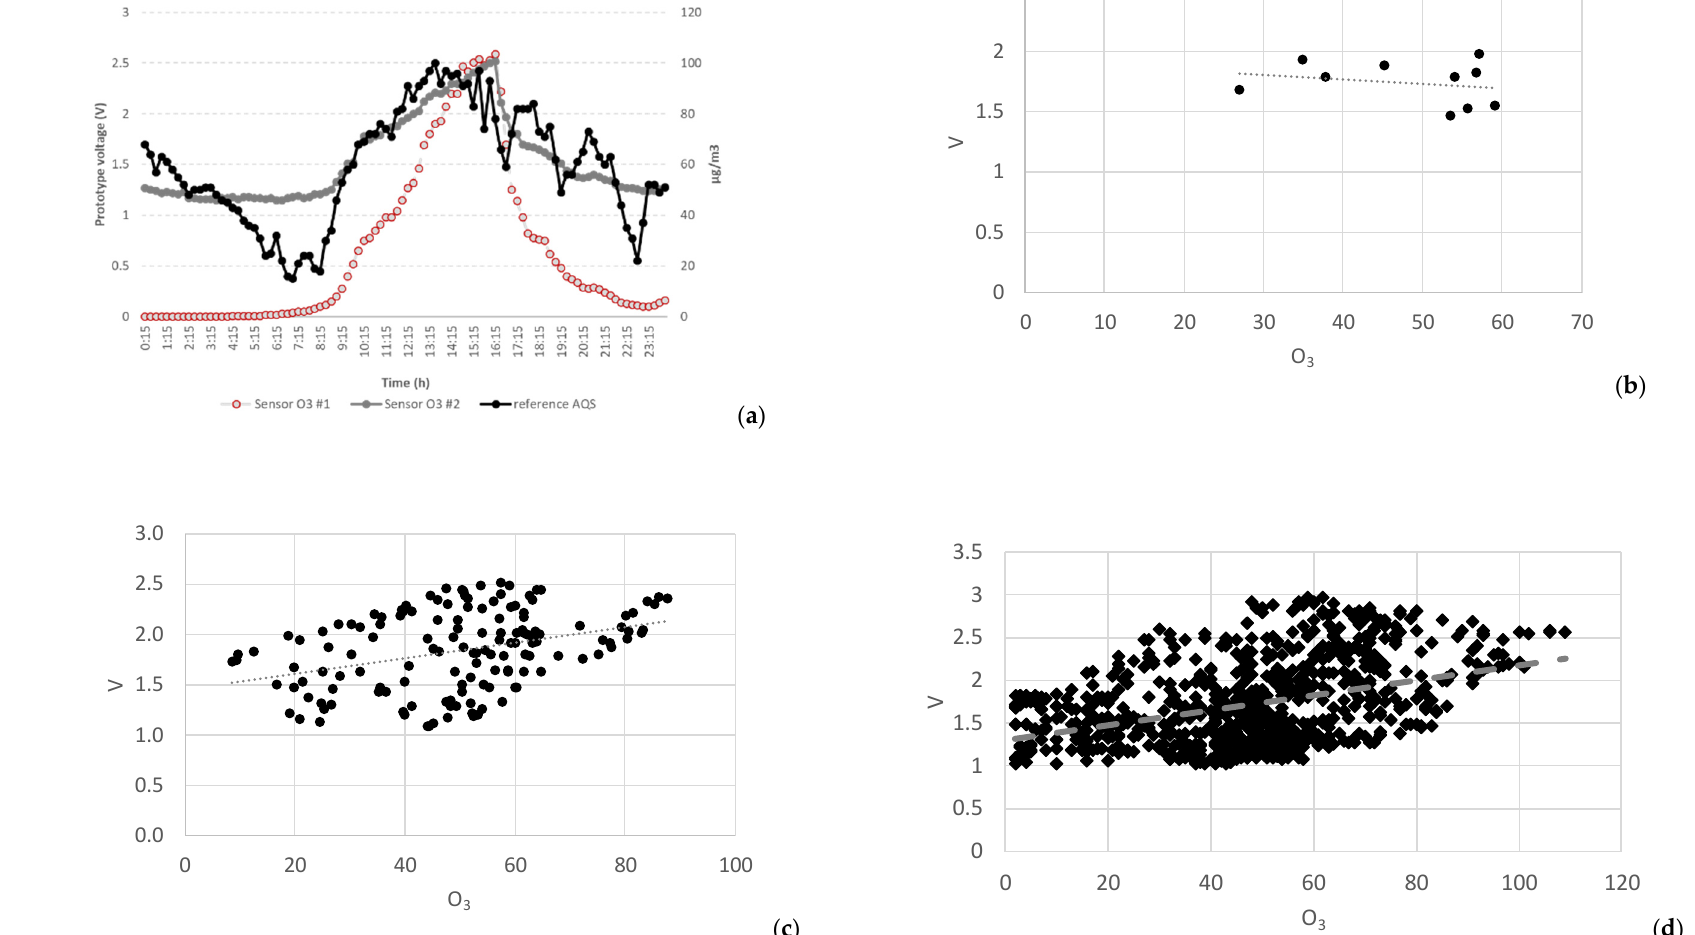
Figure 5. ( a ): O 3 monitored data for a random day (0.25 h); ( b ): 24 h averages; ( c ): 8 h averages; ( d ): 1 h averages.